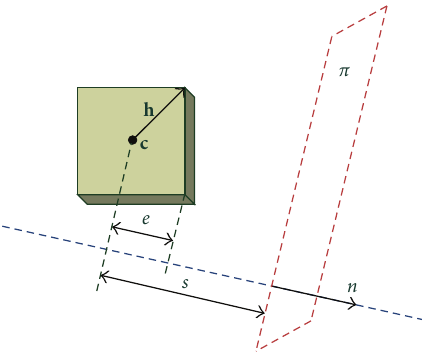
Figure 4: Illustration of the separating plane theorem.